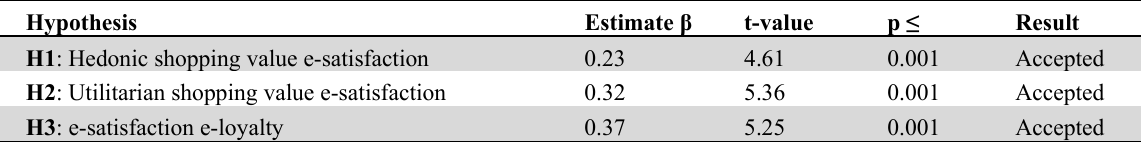
Structural model results Hypothesis